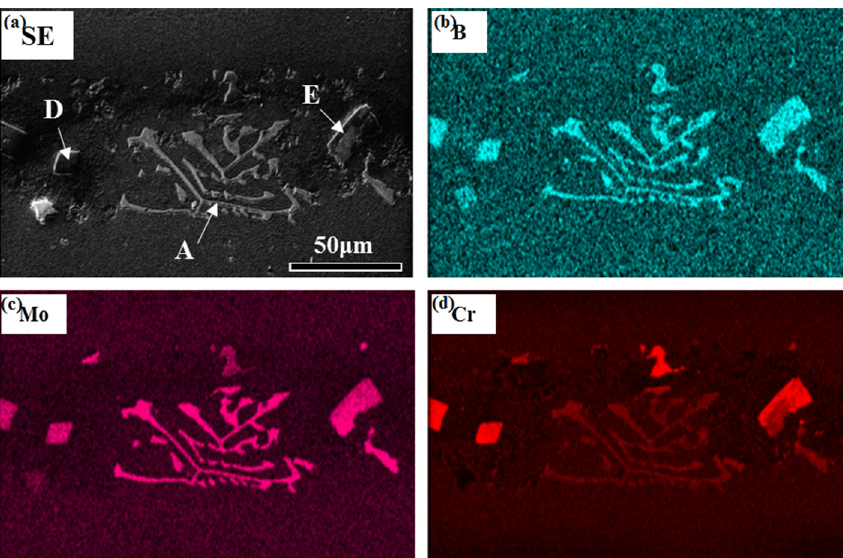
Figure 6. The elemental distribution maps of the as-prepared joint (Area-A, Area-D, and Area-E in the SE image represent skeleton-like white phase, block-like gray phase, and block-like gradient phase, respectively) ( a ) SE image ( b ) B element distribution map ( c ) Mo element distribution map ( d ) Cr element distribution map.